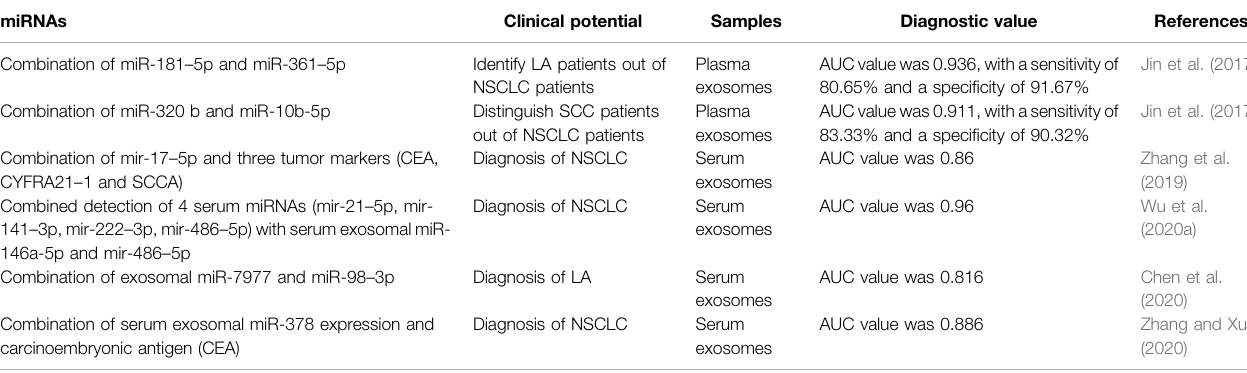
TABLE 2 | Combination for higher diagnostic value in